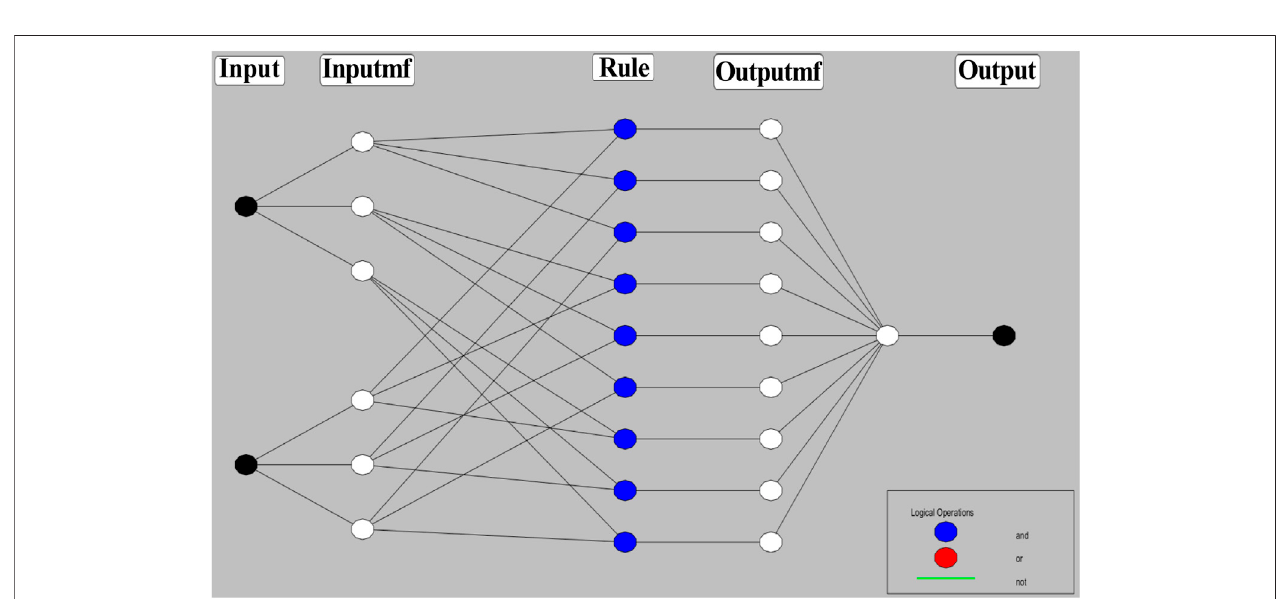
FIGURE 16 | Generated ANFIS structure based on nine